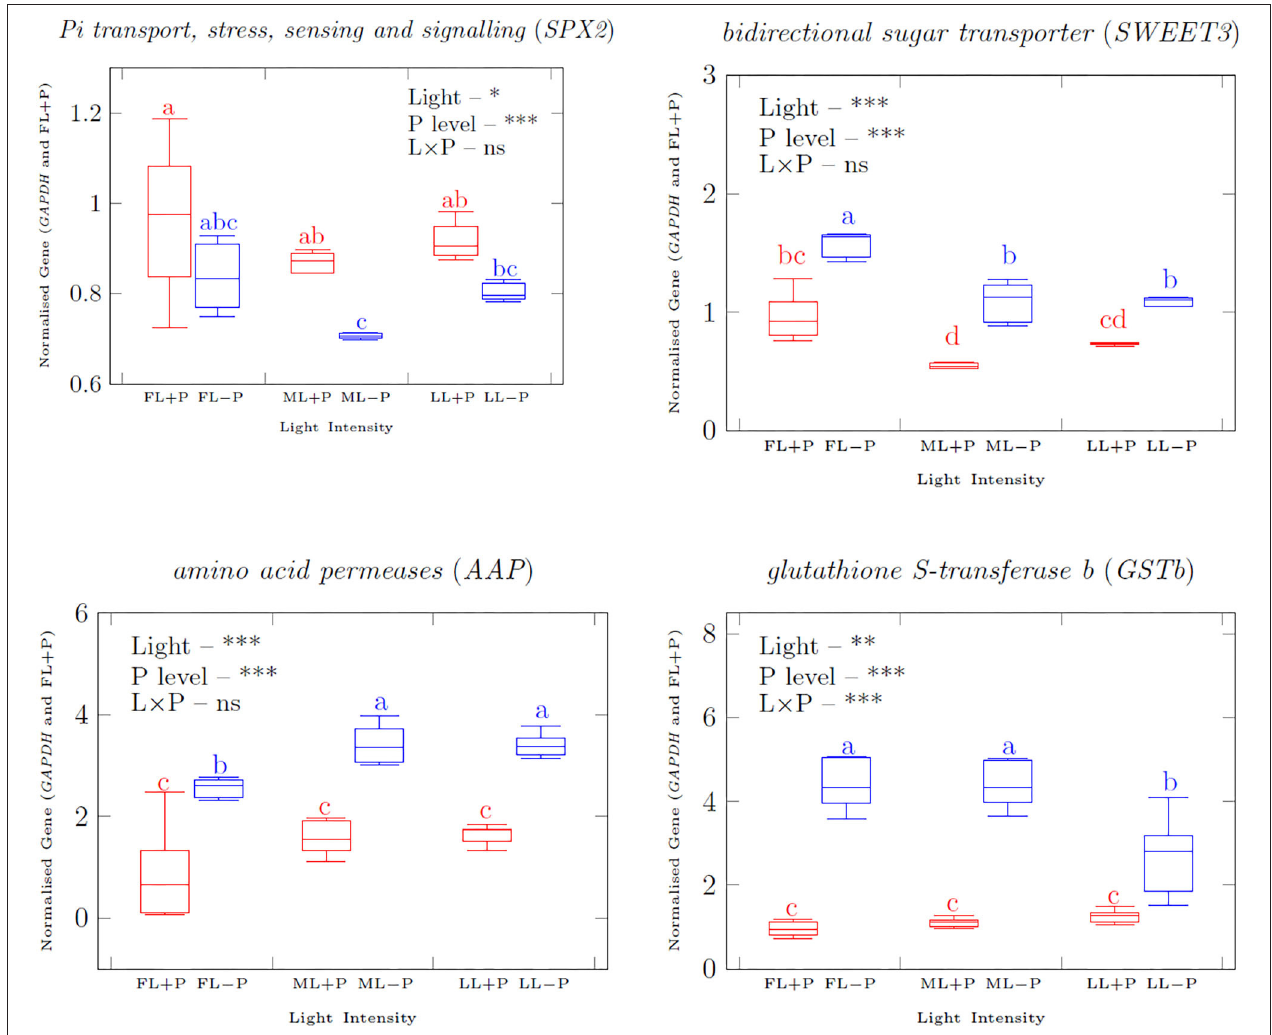
FIGURE 6 | qRT–PCR analyzed (normalized with reference gene delta CT) transporter gene transcripts normalized relative expression in response to full light with + P. Asterisks indicate significant differences: ***is 0.001, ** is 0.01, and *is 0.05, ns, non-significant differences, between light and P